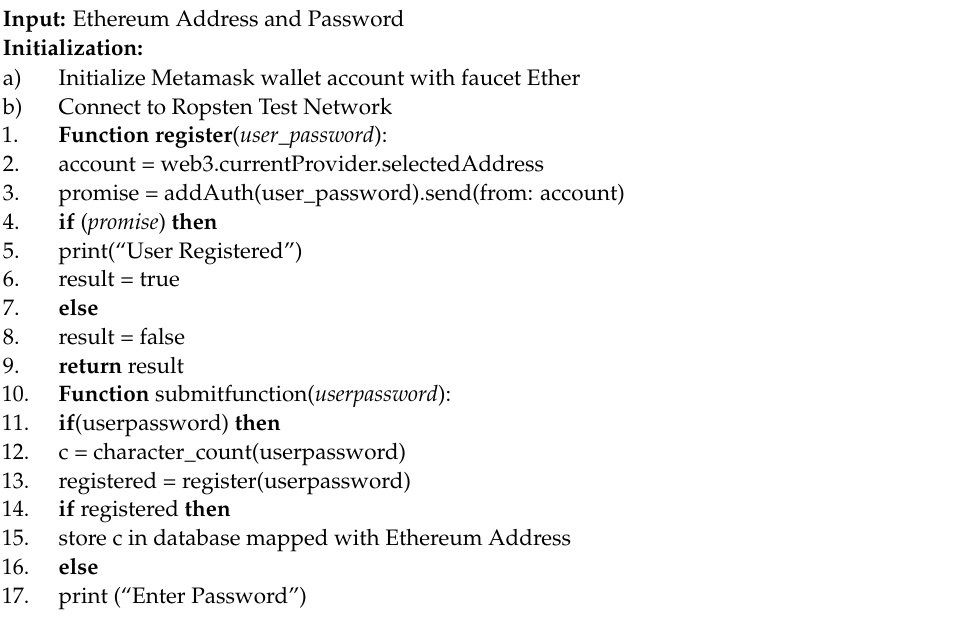
Algorithm 1: Algorithm for Sign-Up/Registration